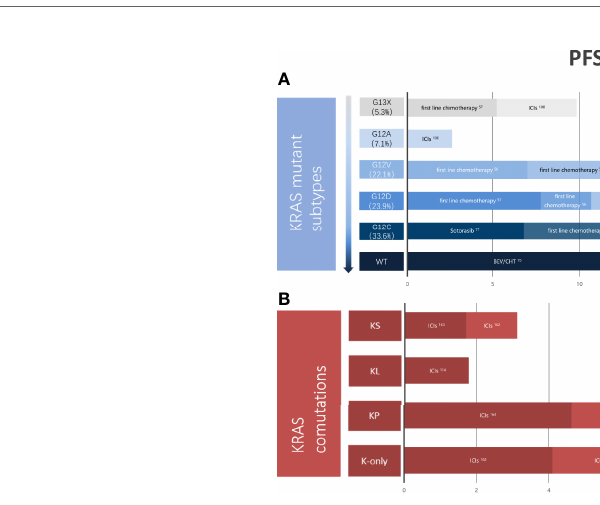
FIGURE 5 | Outcomes vary in primary treatments in different KRAS mutation subtypes or different KRAS co-mutations. (A) Pooled PFS of NSCLC patients with KRAS wild-type and different KRAS mutations from clinical trials. (B) Pooled PFS of K-only and KRAS co-mutated patients with NSCLC from clinical trials. KRAS, kirten rat sarcoma viral oncogene homolog; COD, codon; WT, wild type; ICIs, immune checkpoint inhibitors; BEV, bevacizumab; CHT, chemotherapy; KS, KRAS- SAMARCA4 co-mutant; KL, KRAS-STK11/LKB1 co-mutant; KP, KRAS-KEAP1 co-mutant; PFS, progression-free survival; NSCLC, non-small cell lung